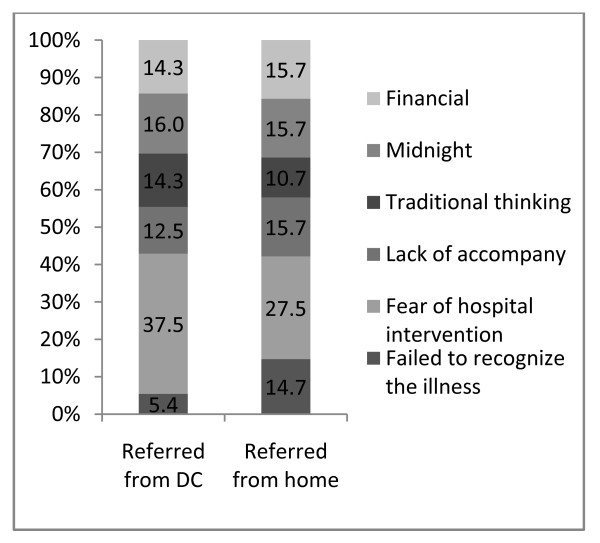
Reasons for delay in making decision for seeking care by places of referral (%)